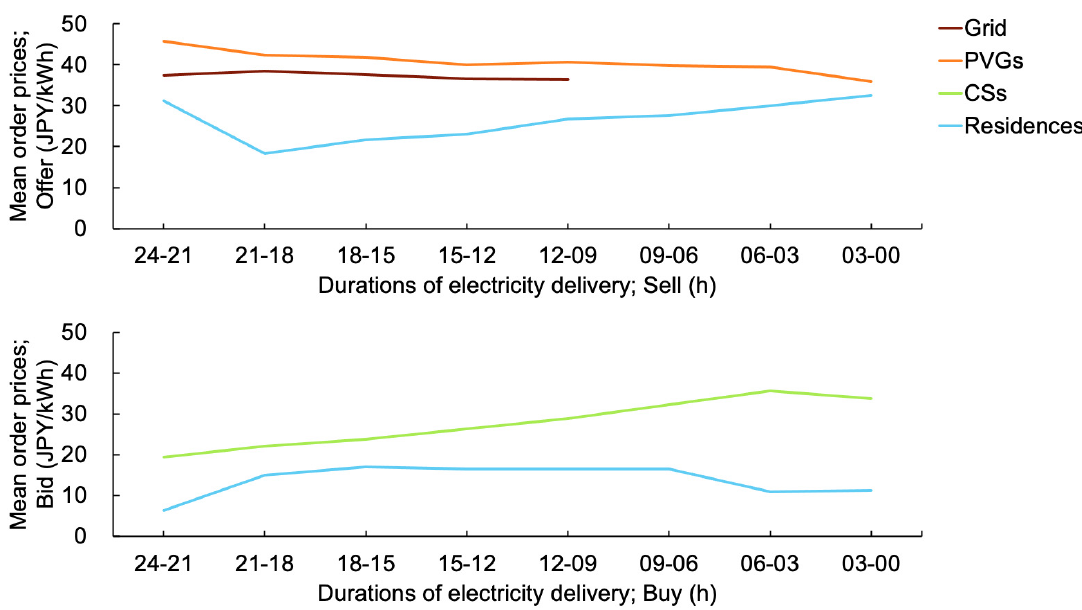
Figure 13. Mean order prices for each electricity delivery duration in the target period.